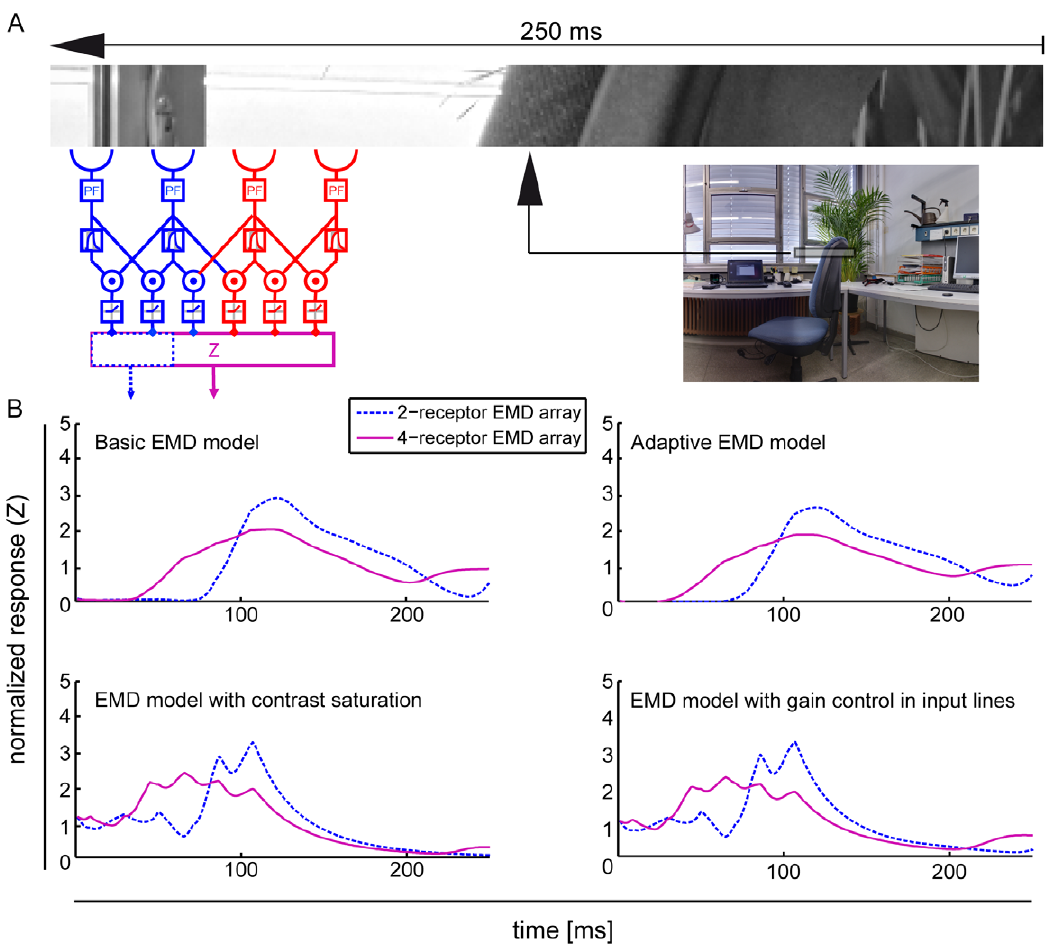
Figure 3. Pattern dependent response modulations of EMD models. (A) Image III (Fig. 2A) sampled by a one-dimensional EMD array, with either 2 (blue) or 4 (blue and red) receptors integrated. Image translates horizontally for 300 ms with a speed of 60 u /s in preferred direction. (B) Normalized EMD responses Z for all models (Fig.1A–D) corresponding to the marked region in the input image. Blue response traces correspond to an EMD array integrating 2 receptors and pink response traces to an array integrating 4 receptors. pattern-dependent modulation amplitude and temporal response characteristics differ between models.